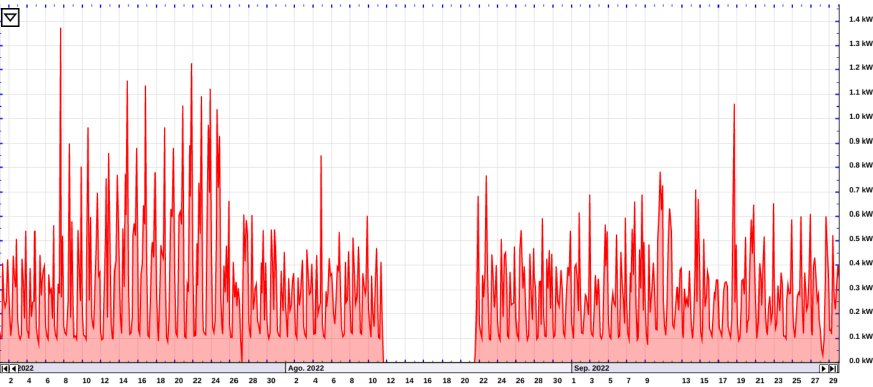
Figure 11. Total power consumption of the main load of the house using the eGauge unit during the period of July, August, and September 2022.